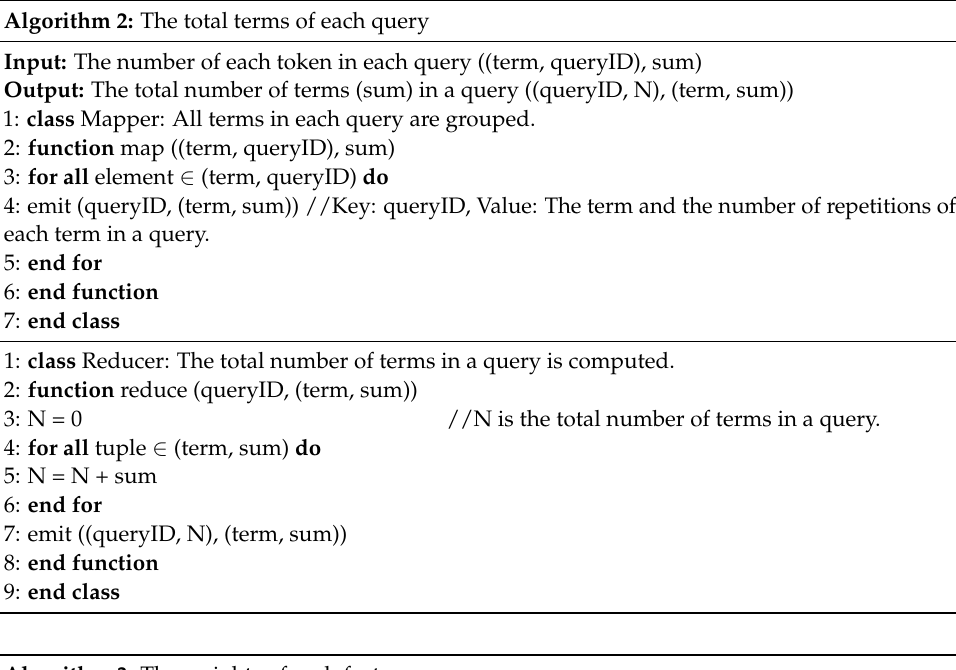
Algorithm 3: The weights of each